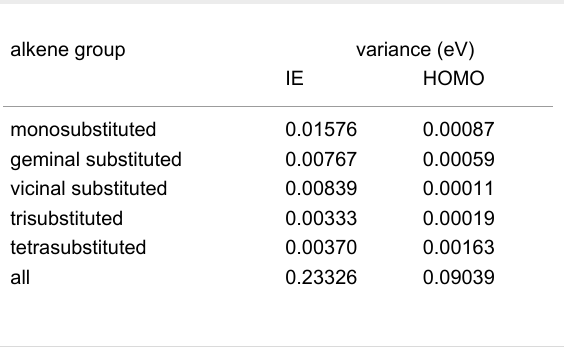
Table 2: Average variance of points in each group based on their corresponding linear